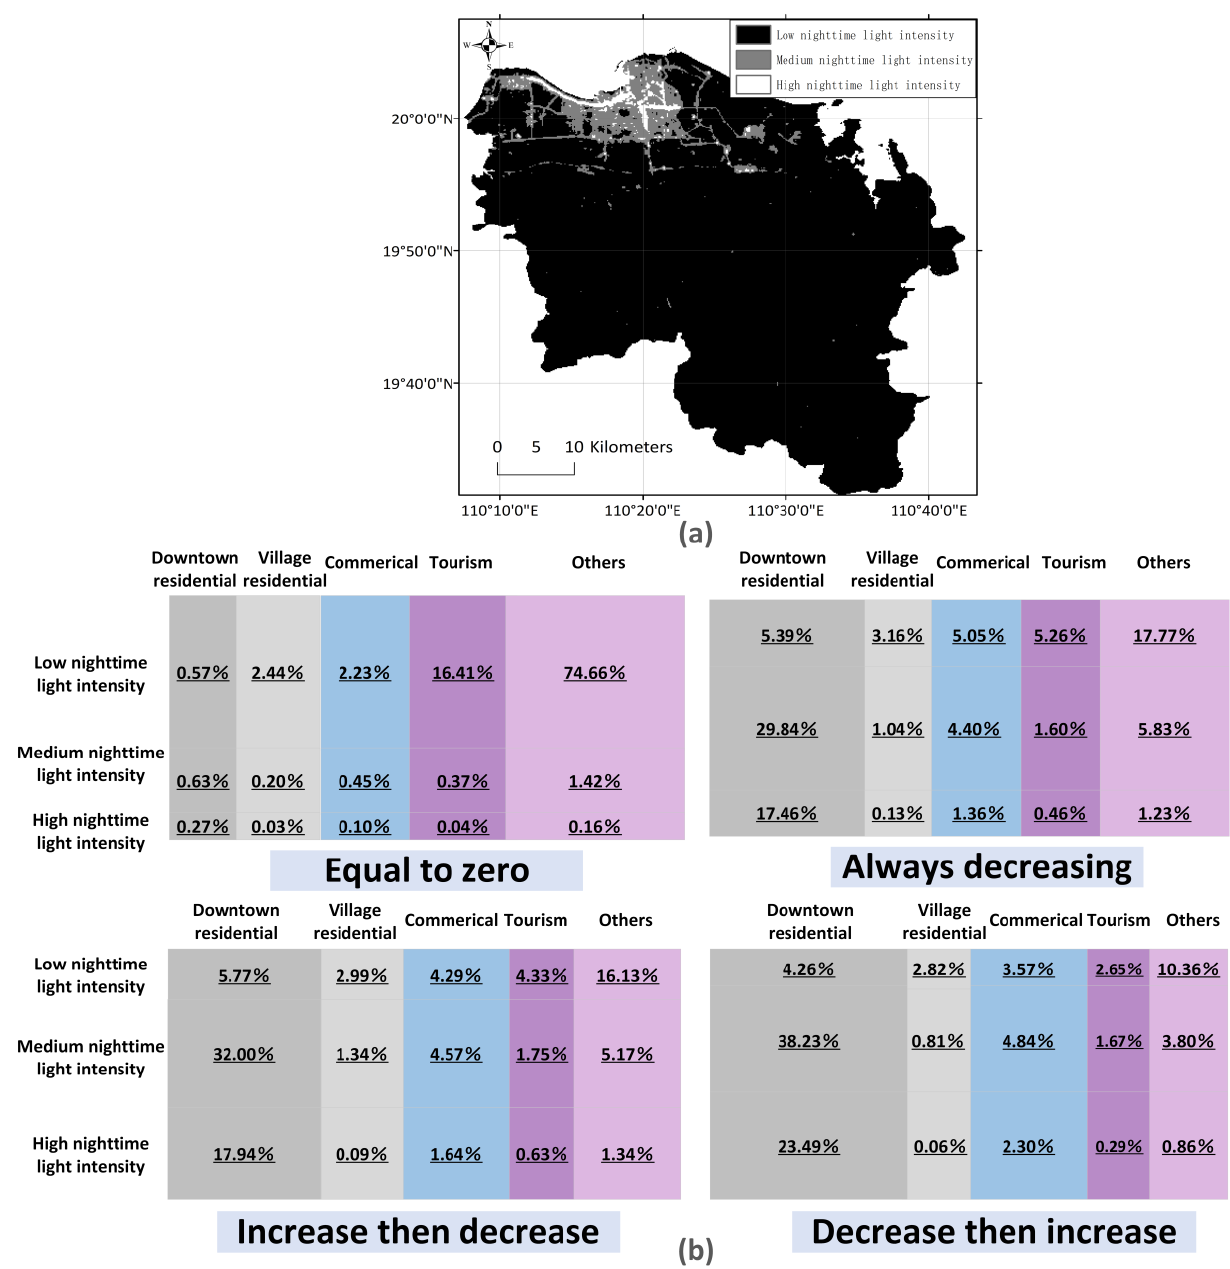
Figure 10. ( a ) Classification results of the nighttime light data in Haikou city after applying the Jenks natural breaks method. We select the nighttime light graded image on 20 September 2018, for display. Based on ( a , b ) which shows the proportions of geogrid with different nighttime light intensities (population densities) and land use types in the four crowd flow clusters. ( b ) includes the average proportions of two-day nighttime intensities.